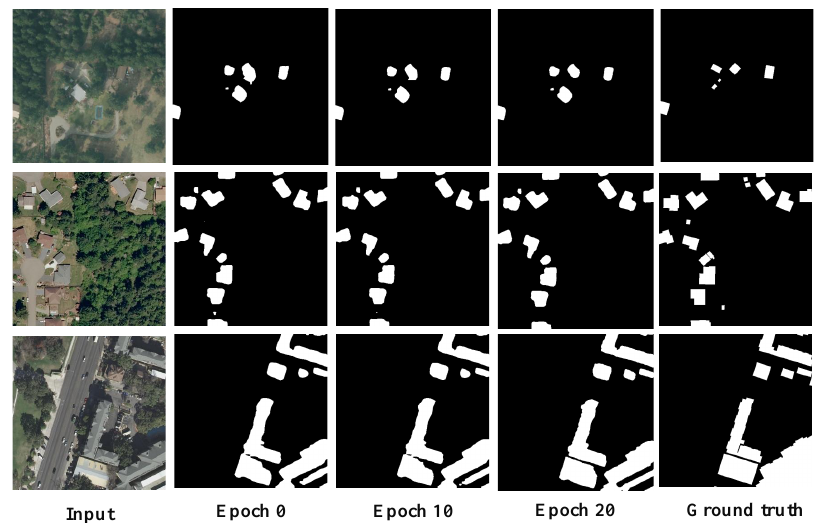
Figure 5. Some pseudo-label examples of remote sensing images semantic segmentation obtained by our AUP method. From left to right are the pseudo labels in different epochs when using